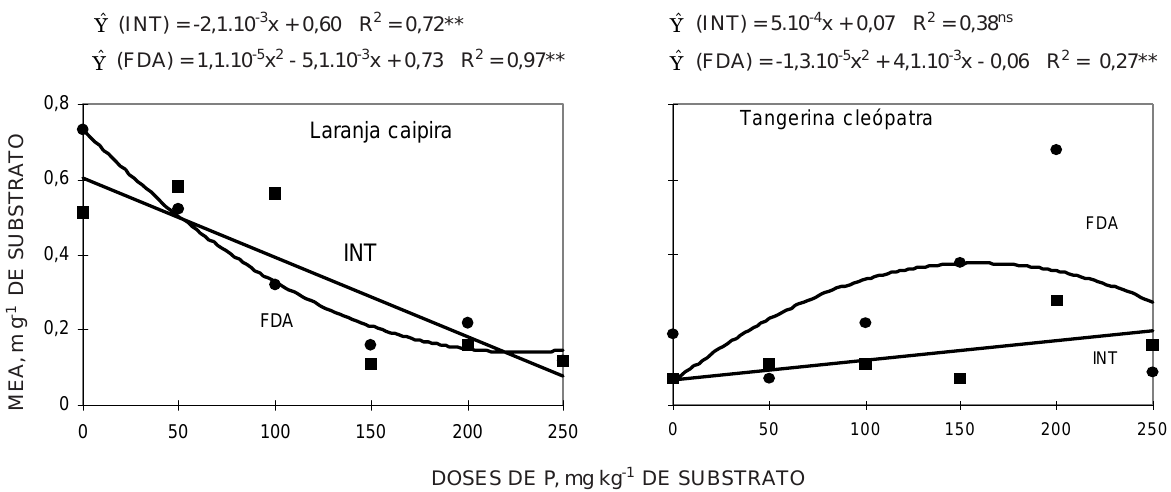
Figura 1. Comprimento de micélio extrarradicular ativo (MEA) de fungos micorrízicos arbusculares para laranja caipira e tangerina cleópatra, pelos métodos de fluorescência induzida (FDA) e redução de iodonitrotetrazólio (INT), considerando as doses aplicadas de P (média de 20